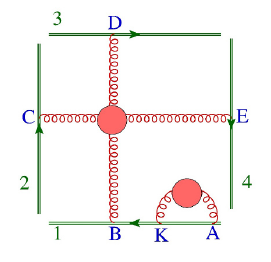
Figure 24. A diagram of Cweb W (1 , 0 , 1)